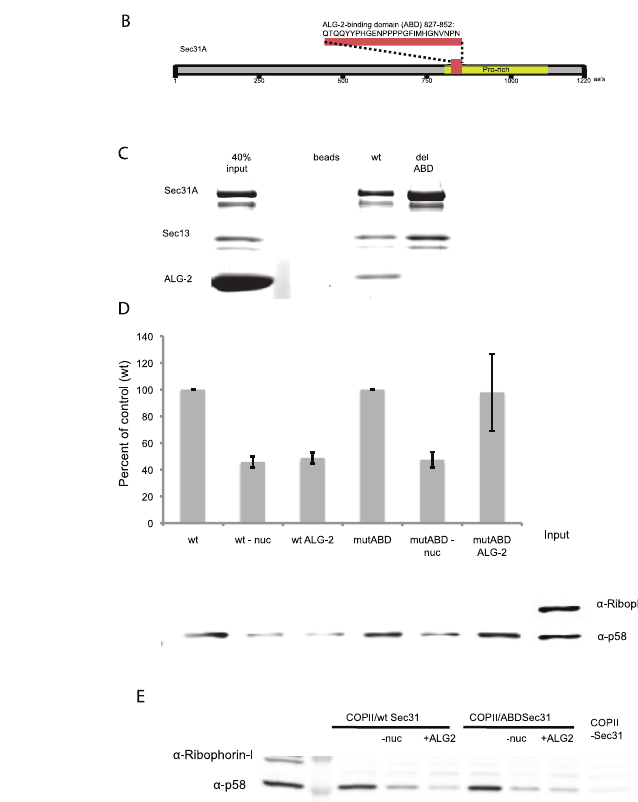
Figure 3. Binding of ALG-2 to Sec31A attenuates COPII budding. A. Peptide array mapping of the ALG-2-binding domain (ABD) of Sec31A. Binding efficiency of fluorescein tagged recombinant ALG-2 binding to 20-mer peptides (upper panel). Various lengths of the indicated proline rich repeats were used as controls (lower panel) B. Diagram representing the ABD of Sec31A and the sequence removed from the Sec31aAdelABD. C. Recombinant ALG-2 was incubated with Ni-beads alone, with purified His-tagged Sec13/Sec31A (wt) or Sec13/Sec31A with the ABD deleted (delABD) in the presence of Ca 2 + . Proteins in the gel were visualized using SyproRed. D. Budding was performed using purified Sar1A, Sec23A/24D and either wt Sec13/31A (wt) or Sec13/31A with the ABD of Sec31A deleted (delABD) in the presence of 0.15 ug ALG-2. Background budding levels were found by omitting nucleotides (-nuc). Budding efficiency was normalized to the Sec13/31A wt and delABD respectively. SEM of three independent experiments. E. Addition of excess (5 m g) ALG-2 inhibits vesicle budding independent of Sec31A.